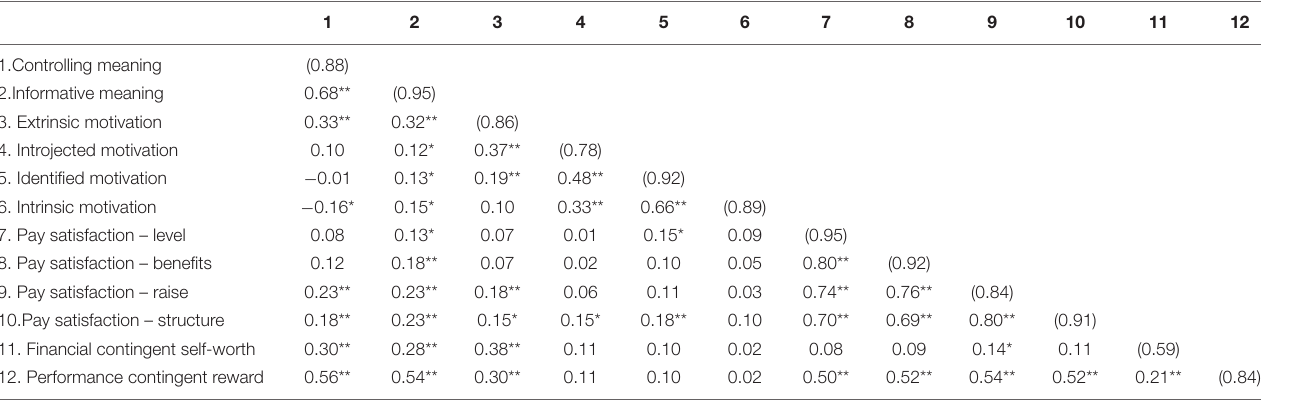
TABLE 9 | Correlations and reliability coefficients along the diagonal for the variables in Study 3 ( N = 260).